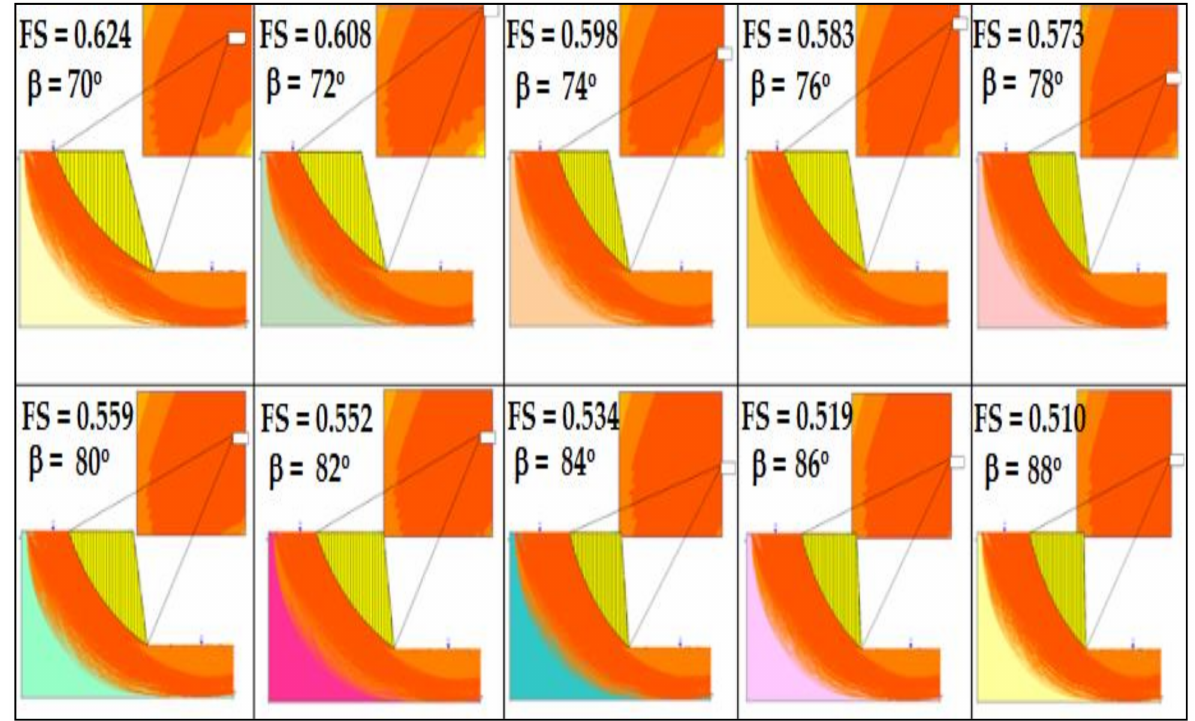
Figure 7. Factor of safety values in the case of Material 1—saturated seismic